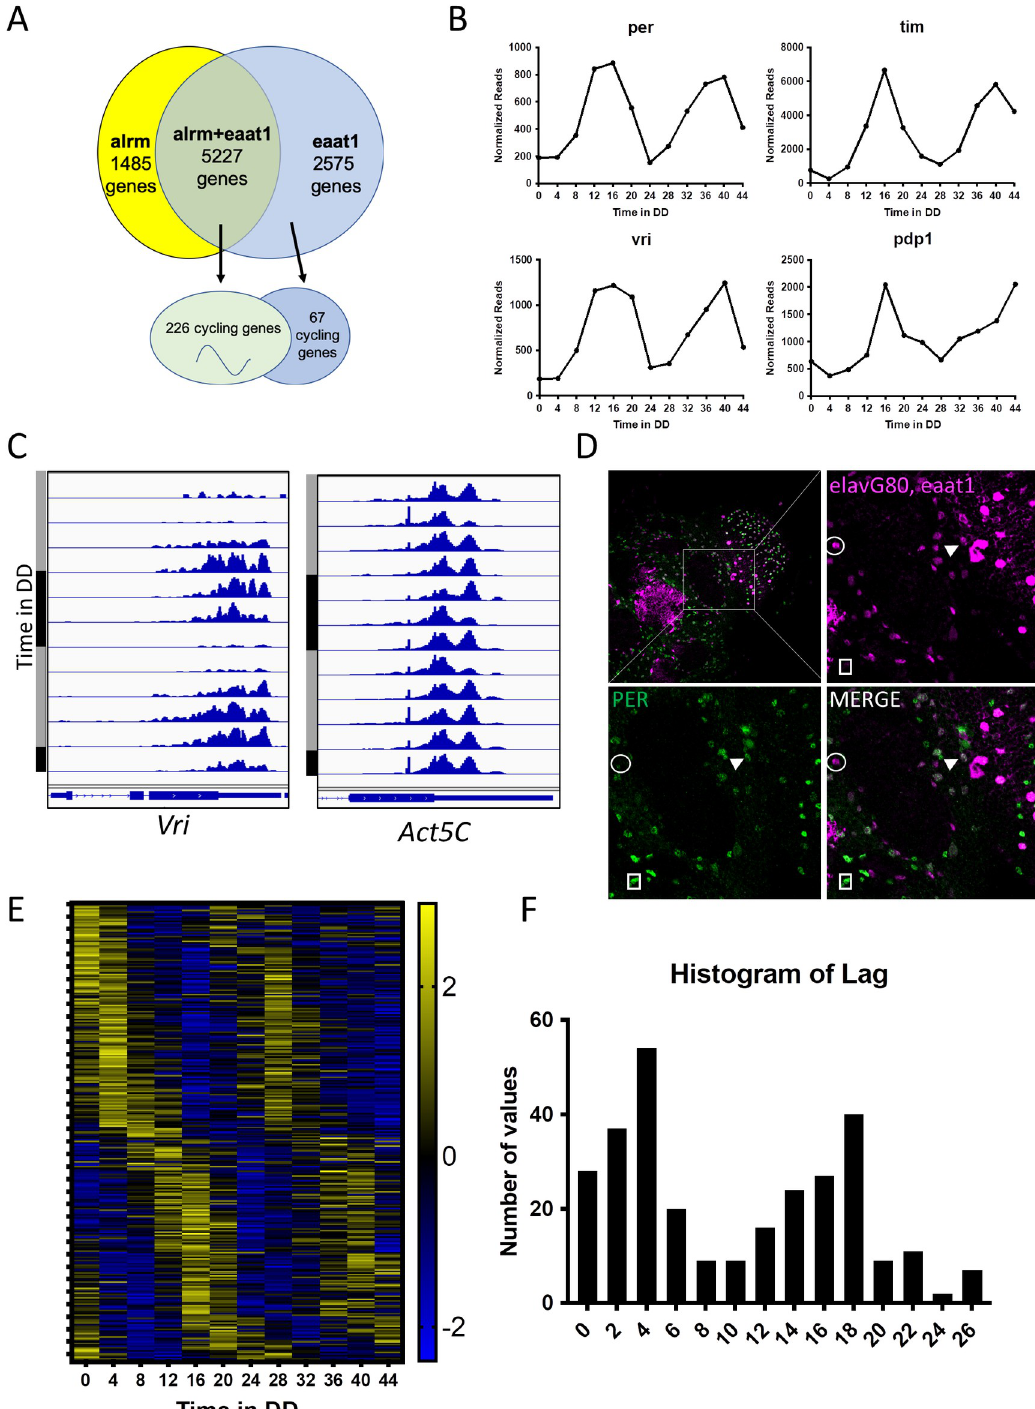
Fig 2. TRAP identifies rhythmic ribosome binding (translation) in astrocytes. A) Comparison of profiled genes in the current eaat1-Gal4 generated study versus a previous alrm-Gal4 generated study [30]. Yellow represents alrm-Gal4 study, blue represents the current eaat1-Gal4 study and green represents the overlap genes. B) Translational profile of select clock genes with the y-axis representing average normalized read counts and the x-axis representing hours in DD. C) Visualization of circadian cycling in sequence reads for the clock gene vri and the housekeeping gene Act5C . Black bars represent night (CT0-11) whereas gray bars represent day (CT12-23). The relevant intron-exon organization for each gene is shown at the bottom of the panels. D)